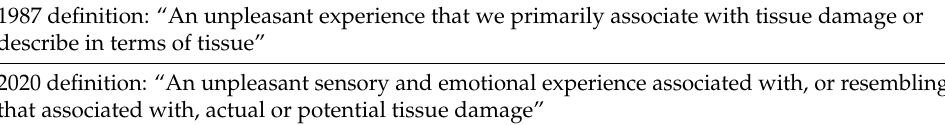
Table 2. IASP definitions of